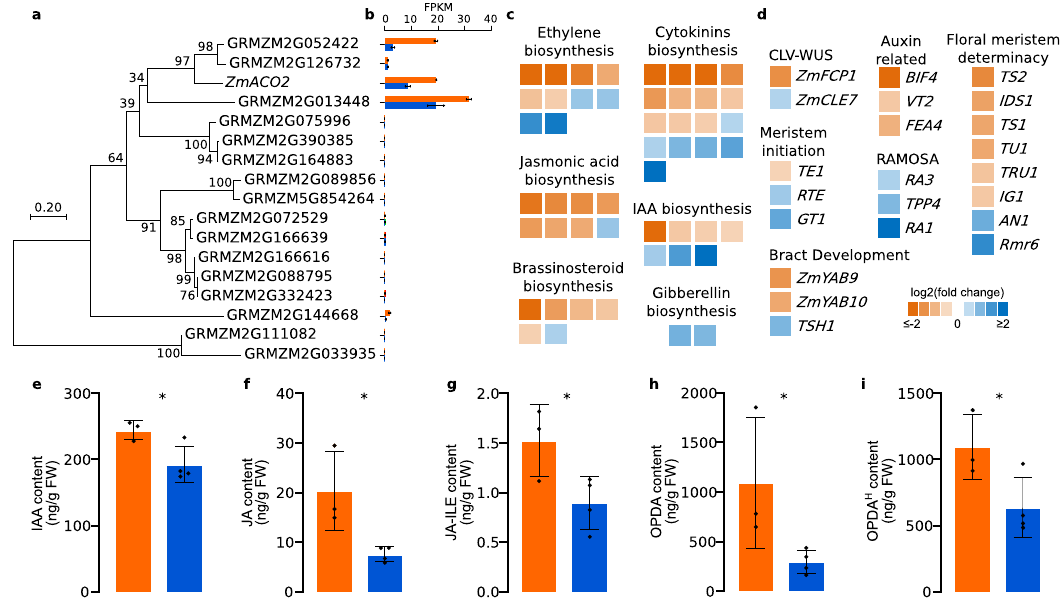
Fig. 5 Expression pro fi ling of developing ears in qEL7 NIL lines revealed that ethylene might cross-talk with other phytohormones and regulate in fl orescence development-related genes. Phylogenetic tree ( a ) of homologous genes of ZmACO2 and their expression levels ( b ) in developing ears of qEL7 NIL lines; numbers on nodes indicate the bootstrap support of the node (1000 bootstrap replicate percentage); scale bar, branch lengths; FPKM values are shown as mean ± SD in qEL7 SL17 (orange bar) and qEL7 Ye478 (blue bar), three biological replicates for each; Expression changes of phytohormones biosynthesis-related ( c ) and in fl orescence development-related ( d ) differentially expressed genes (DEGs) of in qEL7 Ye478 relative to qEL7 SL17 ; the colors from orange to blue represent the log qEL7 Ye478 / qEL7 SL17 ) from less than − 2 to more than 2; the detailed information of gene IDs, 2 ( annotation, FPKM values, p -values and q -values of these genes were listed in Supplementary Data 6. e − i Phytohormone levels in developing ears of qEL7 SL17 (orange bar, three biological replicates) and qEL7 Ye478 (blue bar, four biological replicates) including indole-3-acetic acid (IAA, e , p = 0.016), jasmonic acid (JA, f , p = 0.011), isoleucine conjugate jasmonyl-isoleucine (JA-Ile, g , p = 0.022), and JA precursor 12-oxophytodienoic acid (OPDA, h , i p = 0.029 and 0.025, respectively); phytohormone levels are given in ng per g of fresh weight (FW) as mean ± SD. * p -value ≤ 0.05, from a two-tailed, two-sample t-test; approximately 30 ears were used in each biological replicate in ( e − i